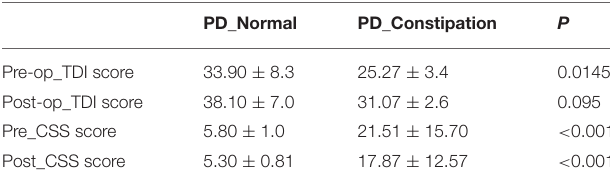
TABLE 3 | DBS had different therapeutic effects on hyposmia between constipation and normal